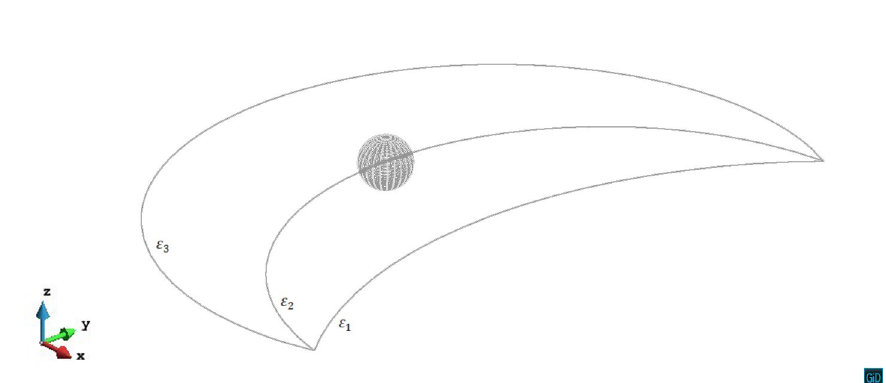
Figure 3. Process of the dislocation line with pinned endpoints passing a misfit spherical precipitate on the slip plane z / R = 0. The plastic strain of different steps ε 1 = 2.13 × 10 − 5 , ε 2 = 5.56 × 10 − 5 , ε 3 = 1.07 × 10 − 4 .